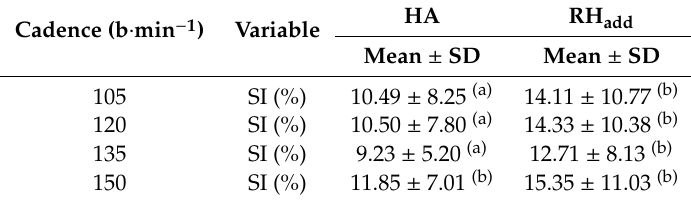
Table 4. Descriptive statistic (Mean ± SD) for the symmetric index